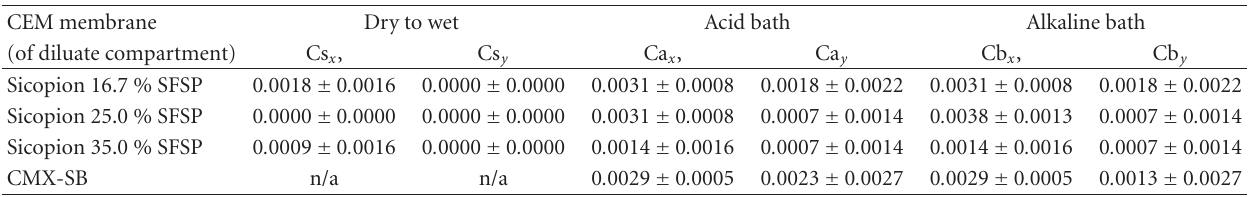
Table 2: Dimensional variation coe ffi cients (in the X and Y dimensions) from a dry-to-wet membrane (Cs x , Cs y ), after an acid bath (Ca x , Ca y ) and after an alkaline bath (Cb x , Cb y ).